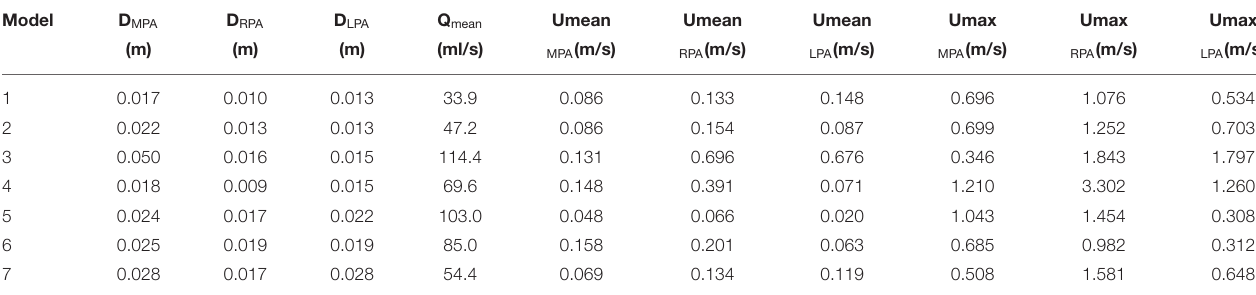
TABLE 2 | Diameters, mean flow rate, and mean and max velocities for the MPA, the RPA, and the LPA branches of each model.